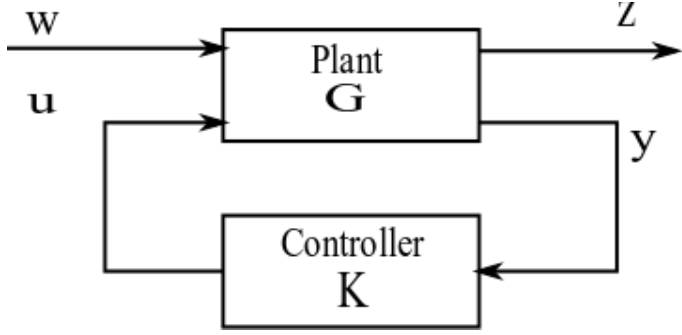
Figure 6. General configuration of the design problem 𝑯 ∞